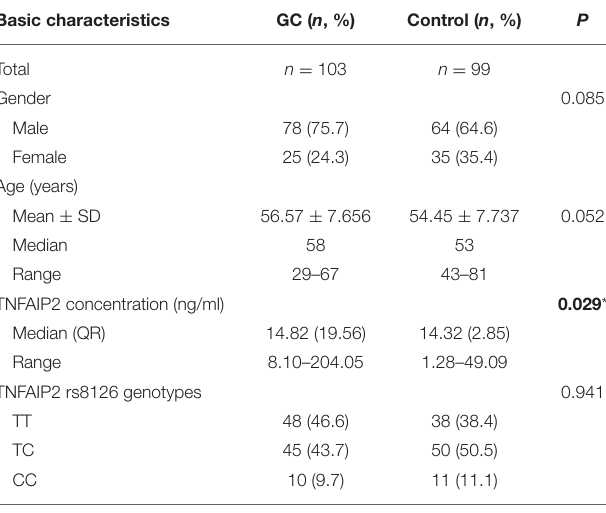
TABLE 10 | The correlation between basic characteristics and survival in gastric cancer (GC) patients. Basic GC patients Death Median survival P -value